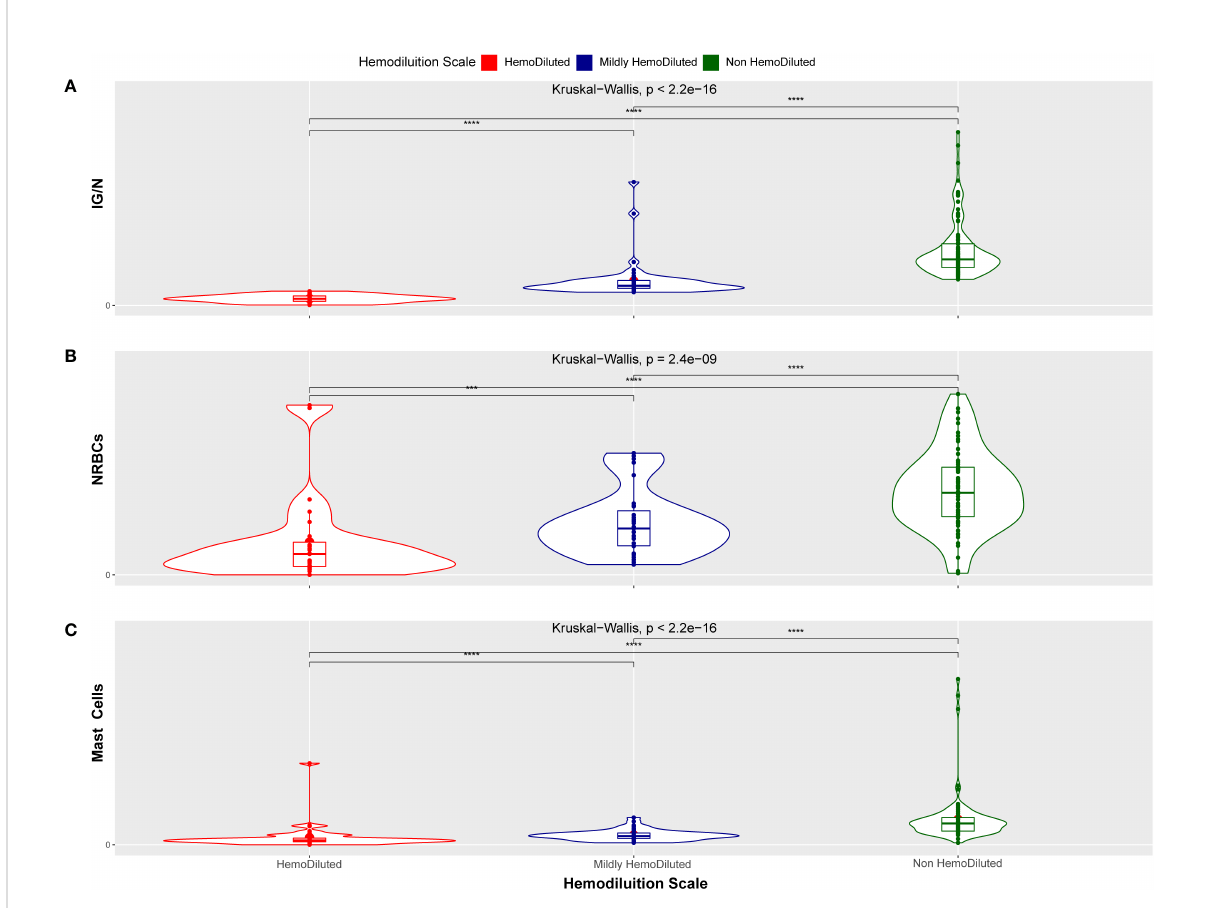
FIGURE 5 Kruskal-Wallis distribution. Hemodiluted (HD, red), mildly hemodiluted (mHD, blue) and non-hemodiluted (non-HD, green) sample distribution related to the IG/N ratio (A) , to the erythroblasts (nucleated red blood cells, NRBCs) (B) and to the mast cells presence (C) . The distribution between groups has a p-value inferior to 2.4e10-9, indicating a statistically highly signi fi cant tendency. (***p < 0.0005 and ****p <